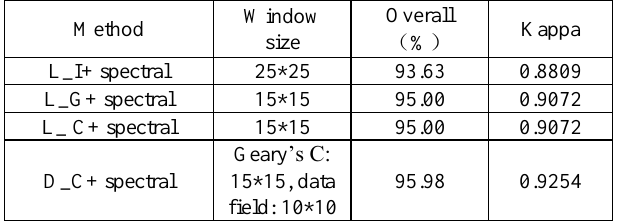
Figure 6 SVM classification results of the test image with (a) L_I + spectral features, (b) L_G + spectral features, (c) L_C + spectral features and (d) D_C+ spectral features Table 3. The classification accuracies achieved by the different texture extraction algorithms with their optimal